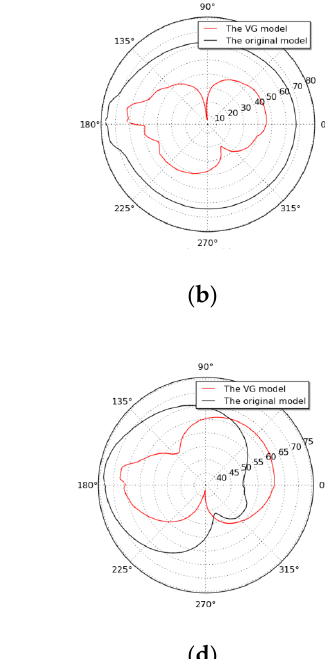
Figure 23. The directivity of the sound field of the two models at different frequencies. ( a ) f = 45 Hz; ( b ) f = 500 Hz; ( c ) f = 1200 Hz; ( d ) f = 1800 Hz.